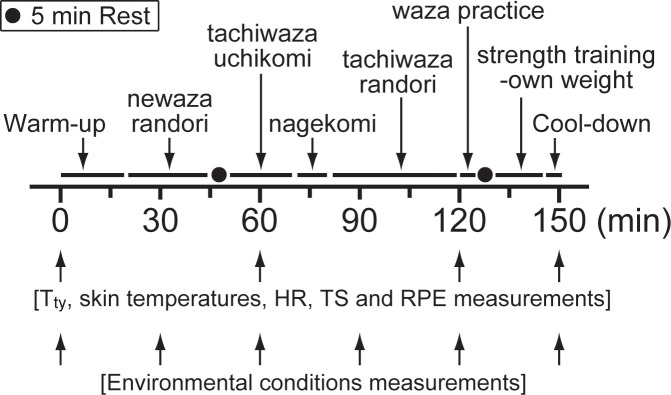
Schematic representation of the experimental protocol.Tty, infrared tympanic temperature; HR, heart rate; TS, thermal sensation; RPE, rating of perceived exertion.